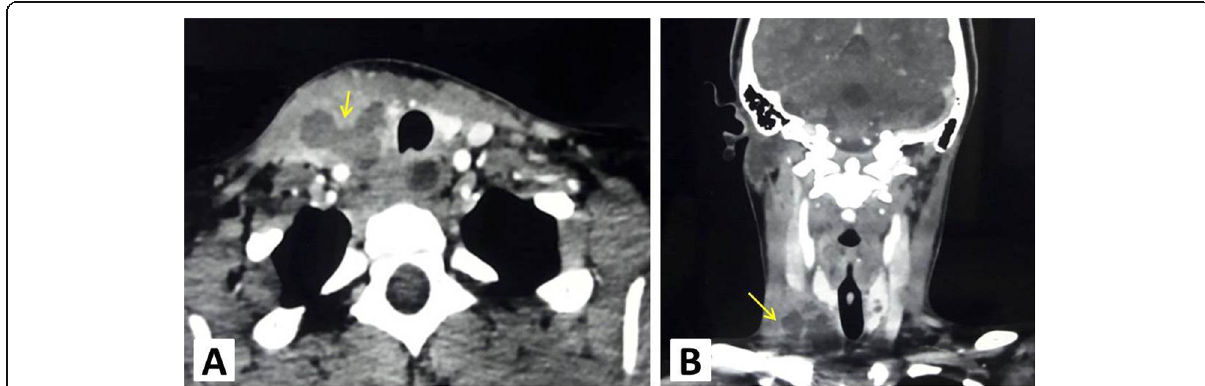
Fig. 1 a Axial view and b coronal view showing a hypodense lesion (arrows) with fluid attenuation and enhanced rim, in the midline, right paramedian, and posterior